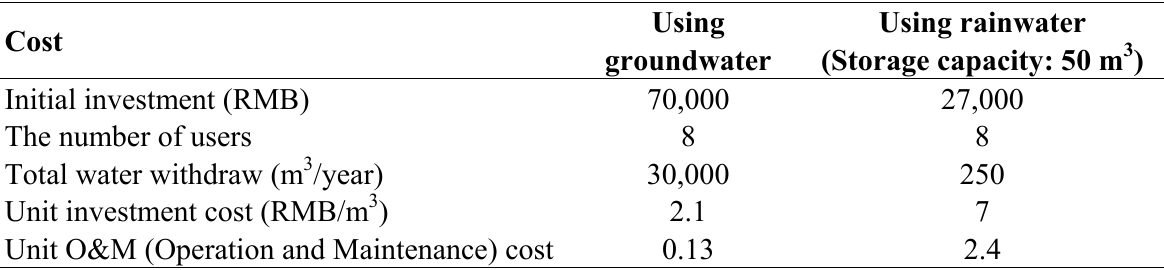
Table 1. Data for cost of groundwater and rainwater for an agricultural